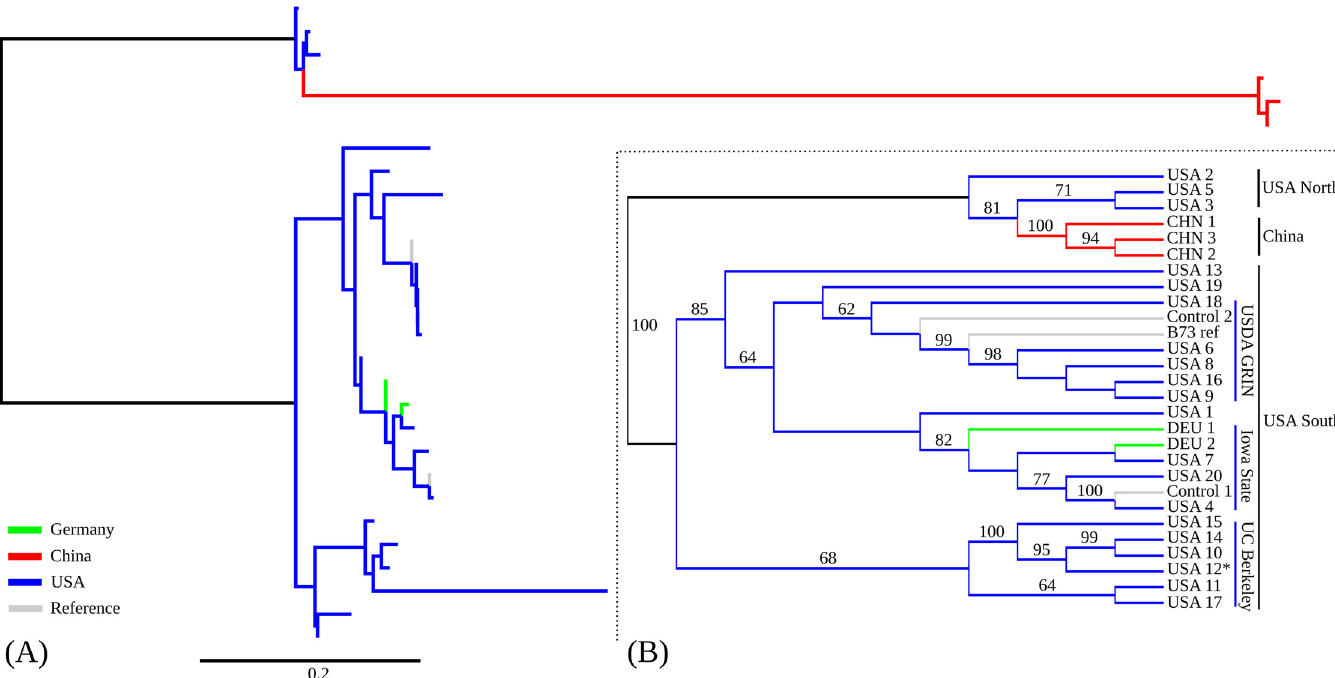
Fig 1. Phylogenetic tree of 27 data sets. (A) Distance-scaled branch lengths; (B) Unscaled tree. Only bootstrap values greater than or equal to 60 are displayed.